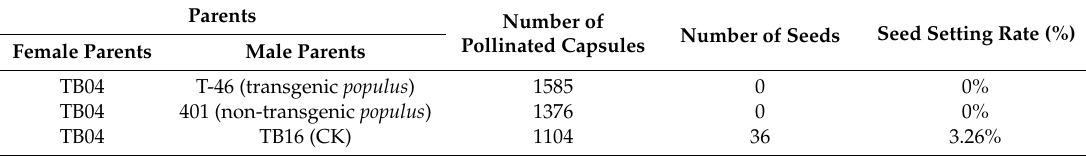
Table 3. Hybridization of T-46 (transgenic Populus ), 401 (non-transgenic Populus ), and TB16 (CK)